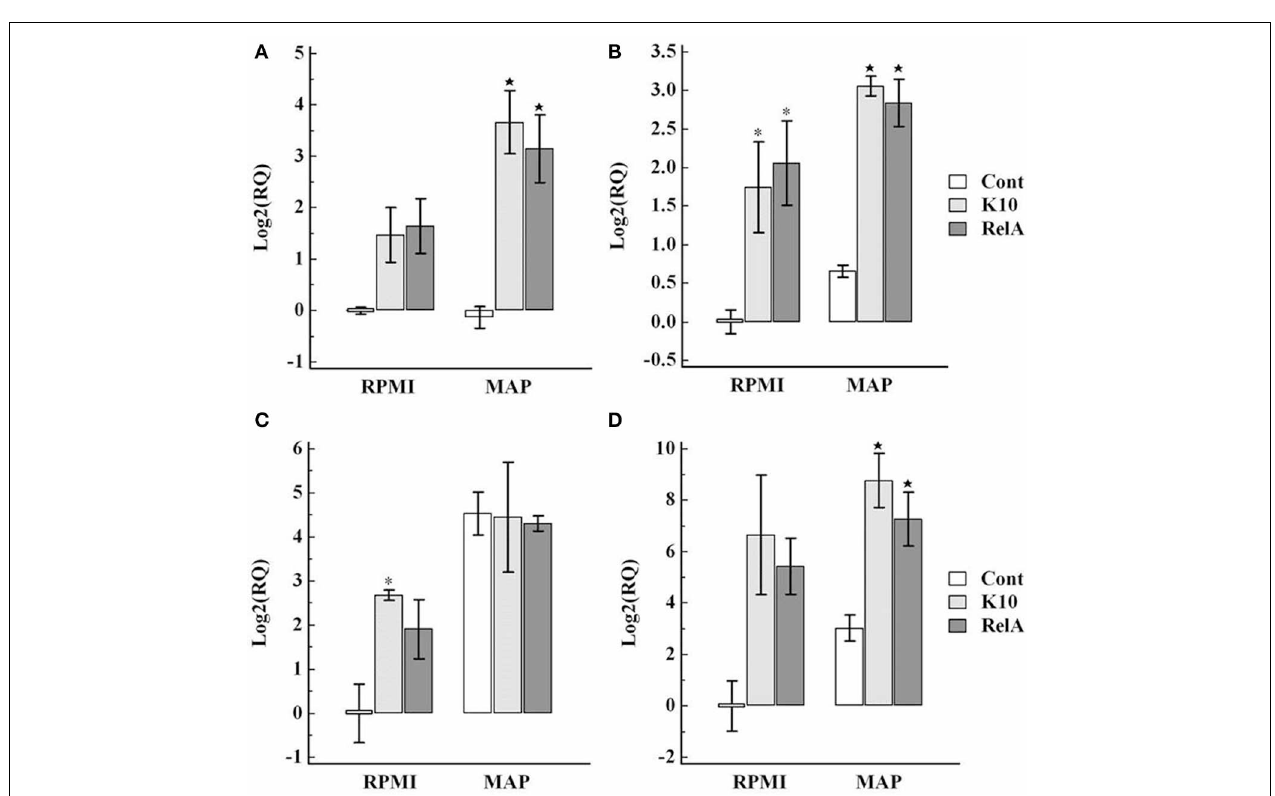
control animals (uninfected animals) and cultured in RPMI medium alone as the calibrator. The panels show the relative quantification of IL-12p35 (A) , Tbet (B) , IFN- γ (C) . RQ, relative quantification; RPMI and MAP , PBMC cultured in RPMI medium alone and with live Map , respectively; ∗ and (cid:2) , significant difference compared to RPMI and MAP of the control group, respectively.